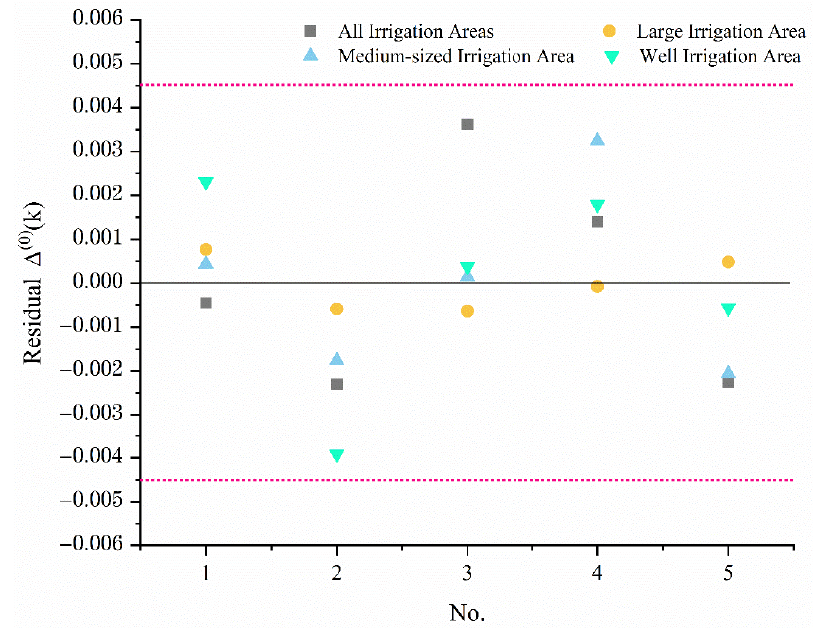
Figure 7. Residuals of various types of irrigation areas ∆ (0) (𝑘) .